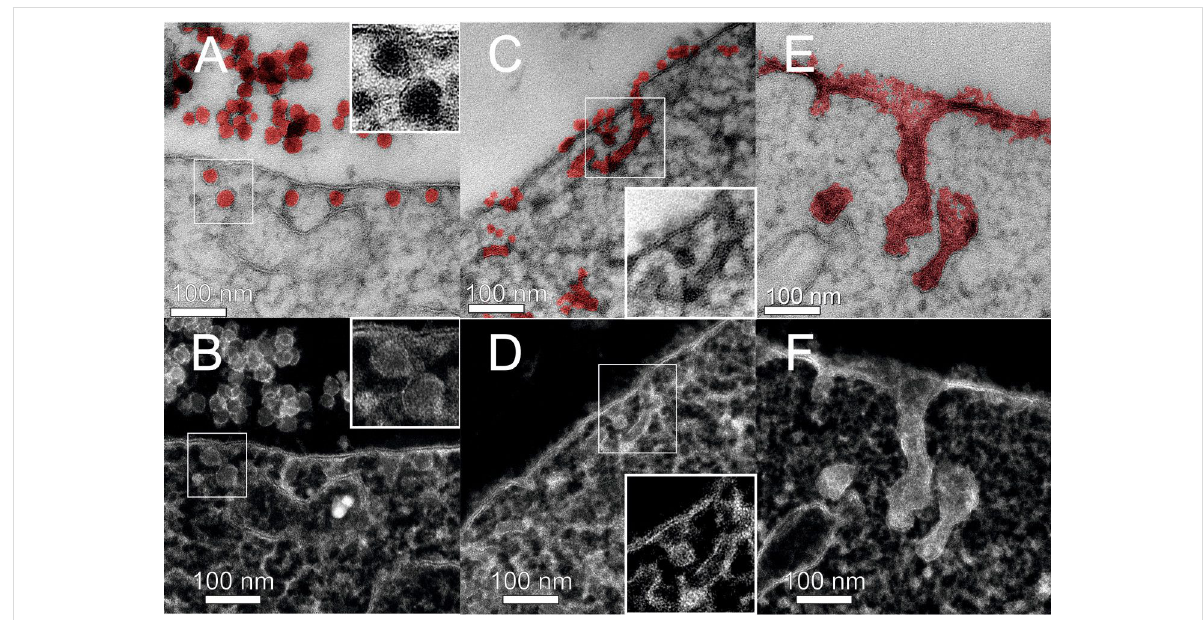
Figure 10: TEM micrographs of high-pressure frozen HeLa cells treated with high concentrations of SiNPs for 2 h, stained with OsO 4 and uranyl acetate. Particle concentrations are c = 3400 µg·mL − 1 for SiNP-22 (A,B), c = 3000 µg·mL − 1 for SiNP-12 (C,D) and c = 3000 µg·mL − 1 (E,F) for SiNP-7. The upper images are bright field micrographs using a pseudocolor for Si containing areas as extracted from energy filtered TEM micrographs. The bottom row (B,D,F) displays the corresponding STEM micrographs with enhanced contrast, clarifying the particle enclosing